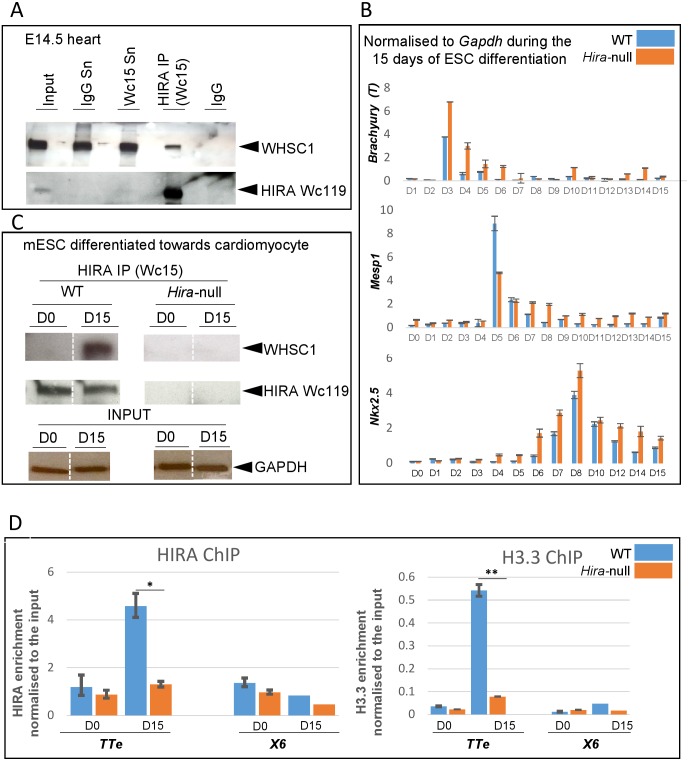
HIRA interacts with WHSC1 and binds to the TTe in the cardiac lineage and heart, and is required for differentiation-associated H3.3 enrichment at this locus.A. 20 E14.5 hearts from WT embryos were isolated, pooled and immunoprecipitated with HIRA Wc15 antibody and immunoblotted with WHSC1. Presence of HIRA in the IP was verified using Wc119 antibody. B. Mouse ESCs (control and Hira-/- ES cells) were differentiated towards cardiomyocytes over 15 days in LIF free medium following the hanging drop method, and were subjected to RNA and protein isolation. qRT-PCR of Brachyury (T), Mesp1 and Nkx2.5 over the 15 days are presented and demonstrate sequential expression of the early mesoderm, cardiogenic mesoderm, and cardiac markers respectively. Data are shown as levels of mRNA normalized to Gapdh and are representative of five independent experiments. Errors bars represent the standard deviation of technical triplicates. C. Protein isolated from undifferentiated ESCs and 15 days differentiated control and Hira-/- ESCs were immunoprecipitated with anti-HIRA Wc15 antibody and immunoblotted with anti-WHSC1 antibody. The results shown are all from the same western membrane but separated lanes are brought into proximity and separated by dashed bars. GAPDH is used as a control for input. D. HIRA and H3.3 qChIP on differentiating ESCs shows an enrichment of HIRA at the TTe at day 15. H3.3 enrichment at the TTe increases significantly in WT but not in Hira null ESCs following this differentiation. X6 is an intergenic negative control region. Unpaired t-test was used: p<0.05 *, p<0.01 **.